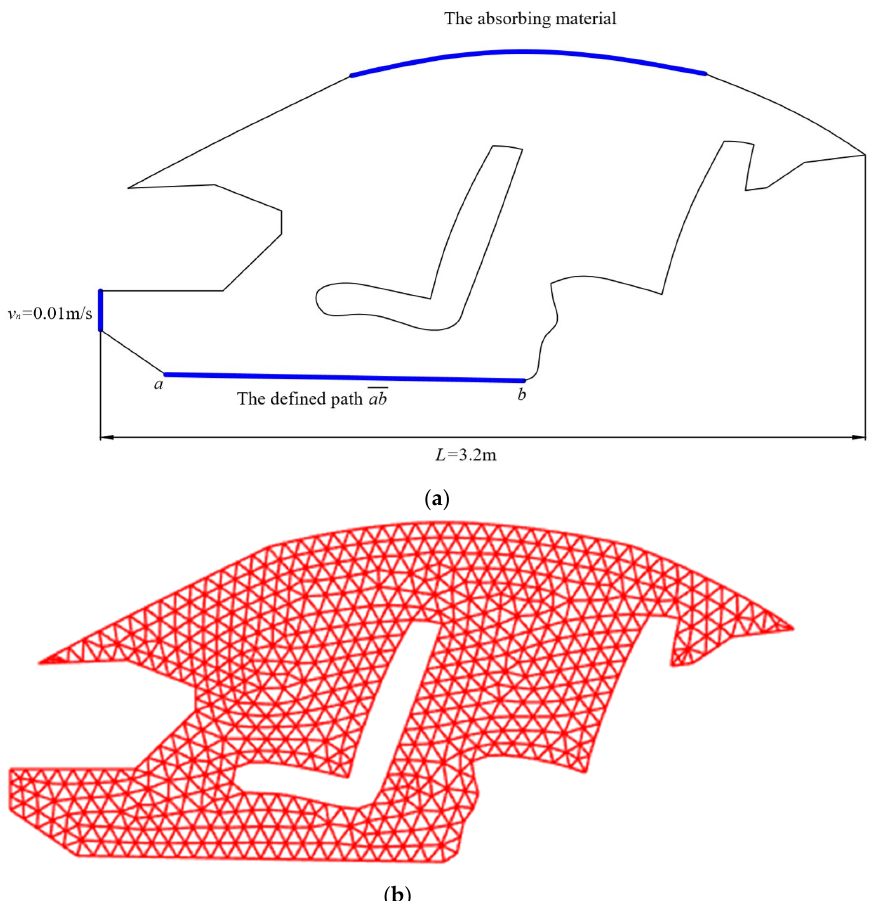
Figure 12. The acoustic propagation in a two-dimensional car: ( a ) the geometry parameters of this two-dimensional car and ( b ) the employed spatial discretization pa tt ern.